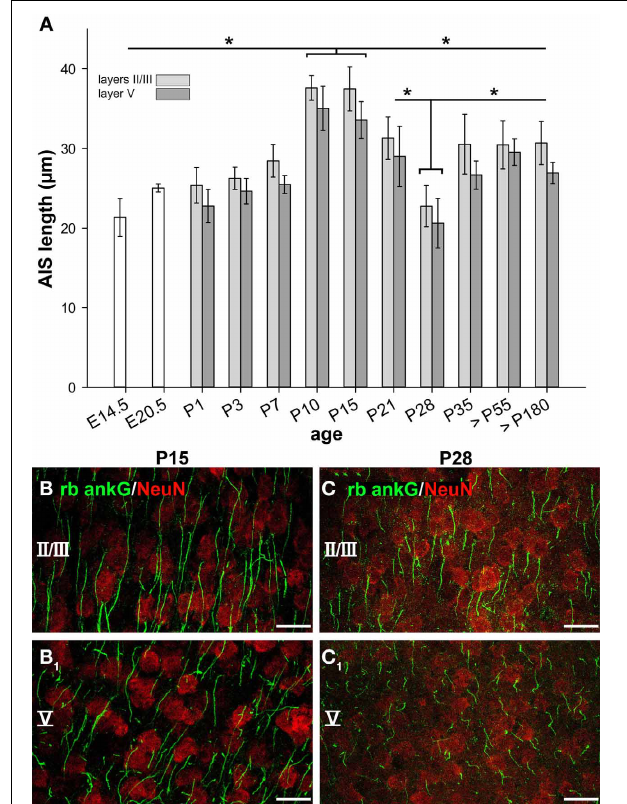
FIGURE 3 | AIS length maturation during visual cortex development. (A) The first AIS appeared at E14.5 often associated with Cajal-Retzius cells. AIS in presumptive cortical neurons increased in length until a maximum from P10-P15. Subsequently, a significant AIS length shortening occurred from the beginning to the peak of the CP in mice (P19–28). Beginning with the closure of the CP at P35, AIS length stabilized, persisting throughout adulthood ( > P180). Similar observations were made for layer II/III and layer V neurons, with layer V AIS showing overall shorter length. (B) Longest AIS expansion in layer II/III neurons at P15 as indicated by ankG (green) and somatic NeuN (red). (B 1 ) Layer V image from the same cortical section as in (B) . (C 1 ) Significant AIS length shortening in layers II/III in a P28 animal as compared to AIS length shown in (B) . Layer V image from the same cortical section as in (C) with shorter AIS. Scale bars (B–C 1 ) = 25 μ m. ∗ p ≤ 0 . 05, standard